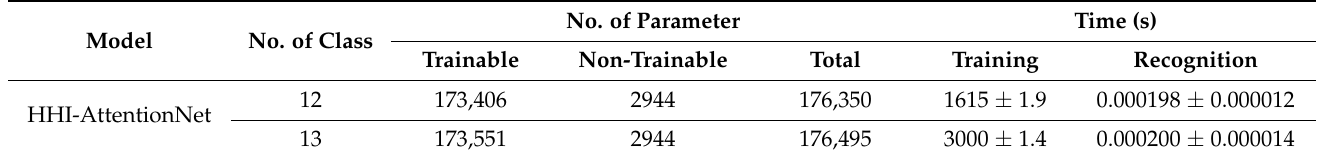
Table 4. Parameters and times of the proposed HHI-AttentionNet model.